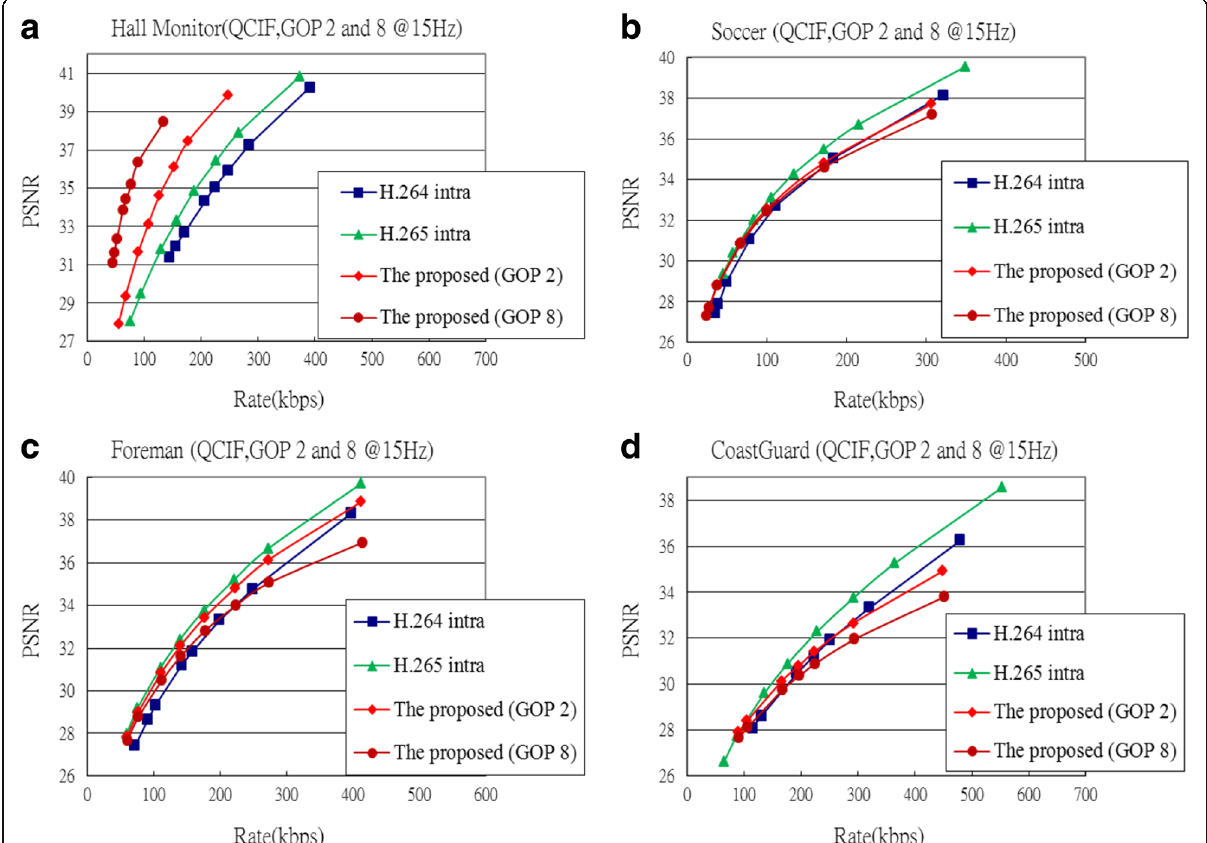
Fig. 12 The RD performance of the proposed scheme compared to that of